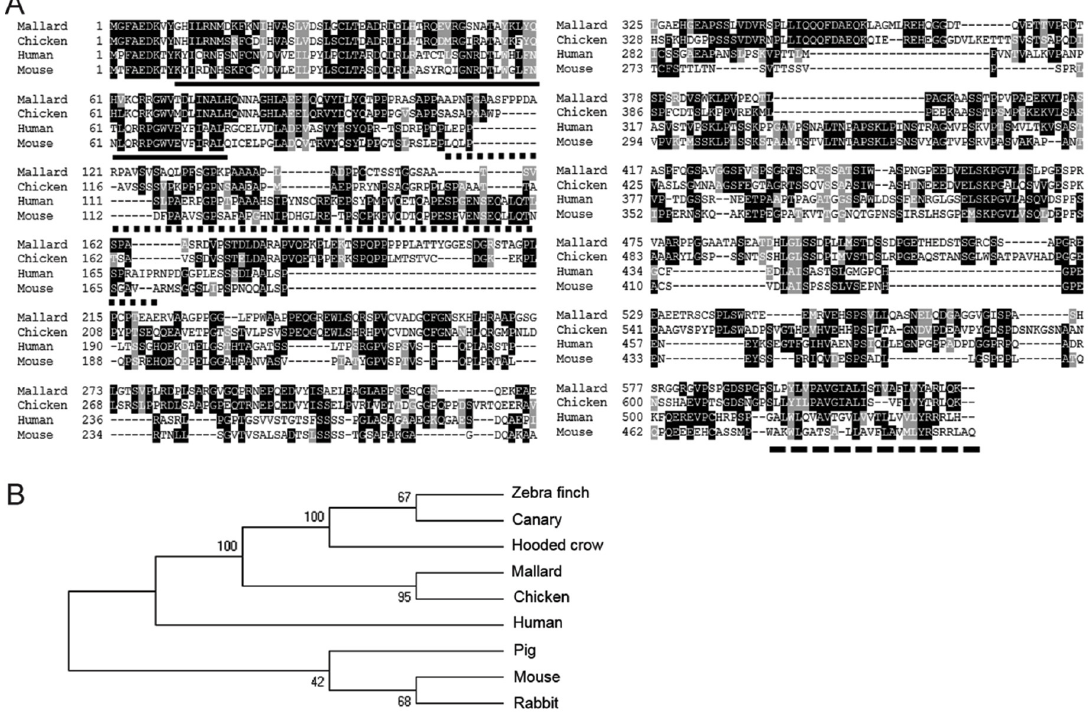
Figure 1. ( A ) Mitochondrial antiviral signaling (MAVS) sequences are poorly conserved between species. Amino acid alignment of duck, chicken, human, and mouse MAVS proteins was performed with Clustal Omega and edited with Boxshade. Black and grey shading indicates identical and similar amino acids (50% threshold). The solid line, dotted line, and dashed line indicate the caspase activation and recruitment domain (CARD), proline-rich region, and transmembrane domains, respectively. ( B ) Phylogenetic analysis of MAVS proteins. The bootstrap consensus tree was inferred using the Neighbor-Joining method from 1000 replicates using MEGA7. MAVS protein sequences were downloaded from the NCBI protein database (Table S2).